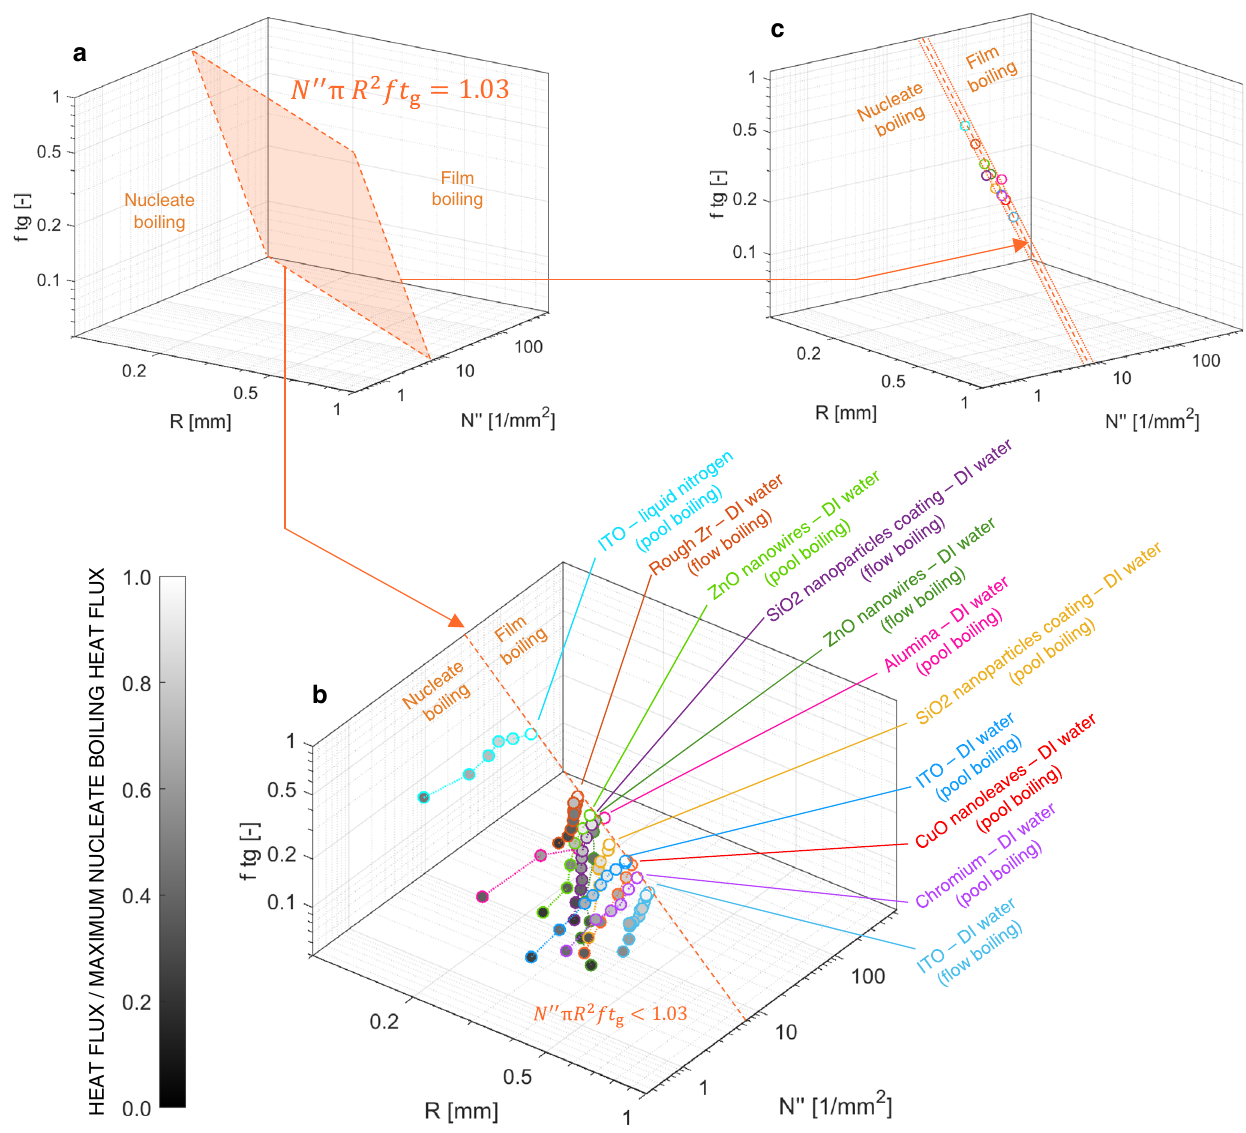
Fig. 3 | The unifying criterion of the boiling crisis. a Critical surface determined using the stochastic model. b Representation of the experimental boiling triplets ( N 00 , R , ft g ) for several boiling surfaces and operating conditions (Source data are provided as a Source Data fi le). The dot grayscale is proportional to the ratio betweentheheat fl uxandthemaximumheat fl uxthateachsurface(representedby different line colors) can remove in nucleate boiling. White dots indicate the